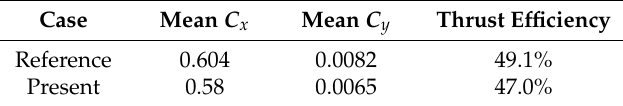
Figure 7. Performance curves of caudal fin.